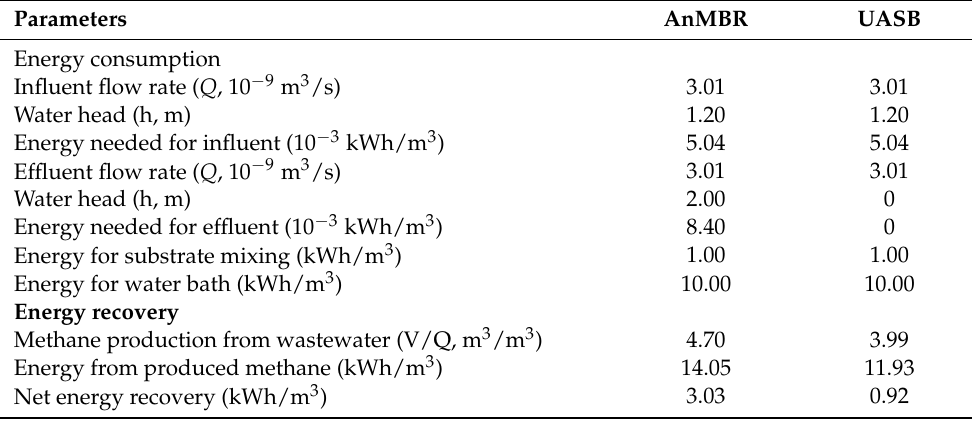
Table 3. Energy balance calculation in AnMBR and UASB during the